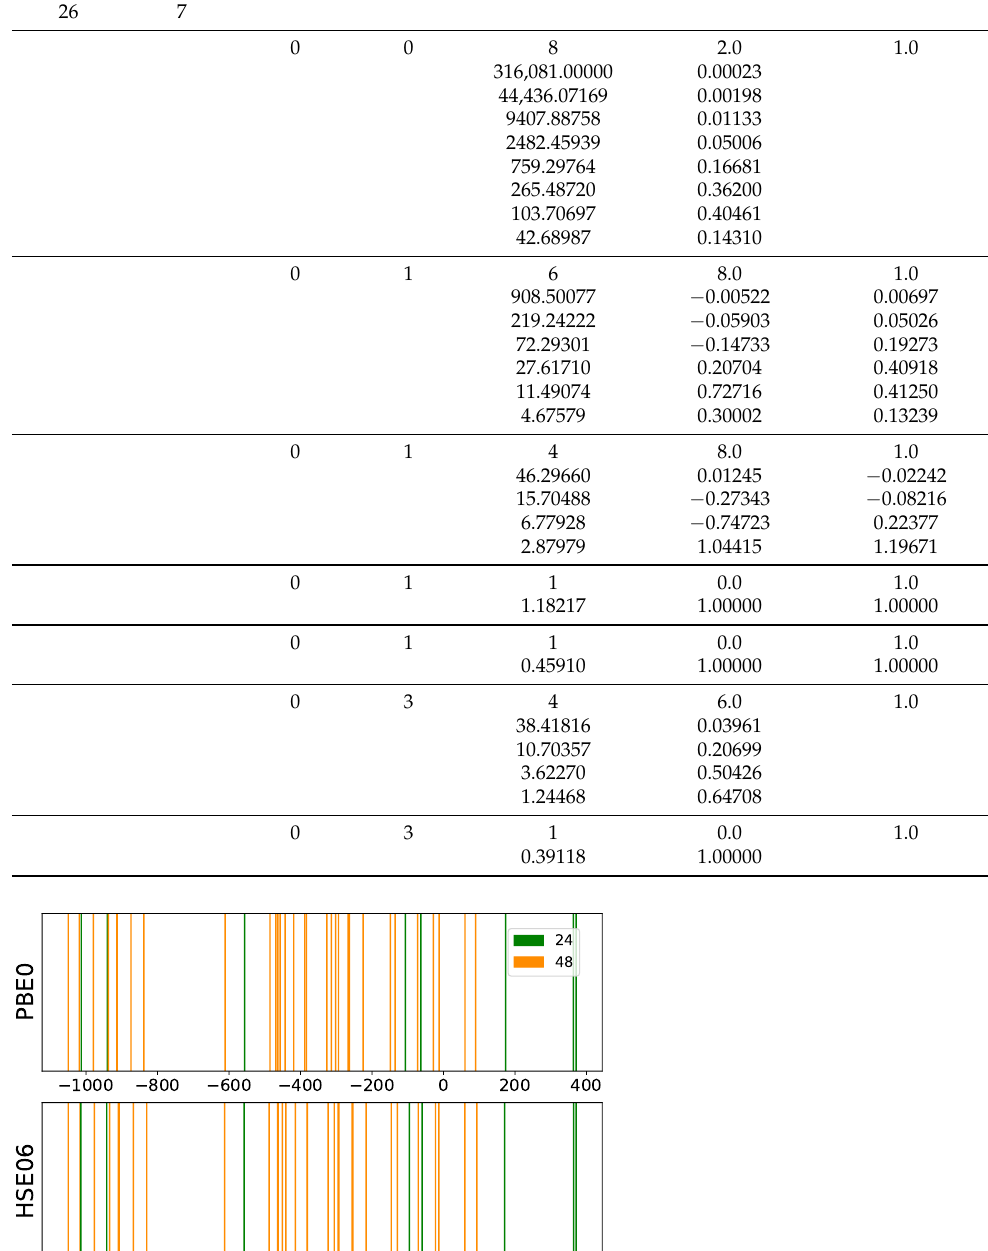
Table A1. Fe all electron basis set used in the present calculations.